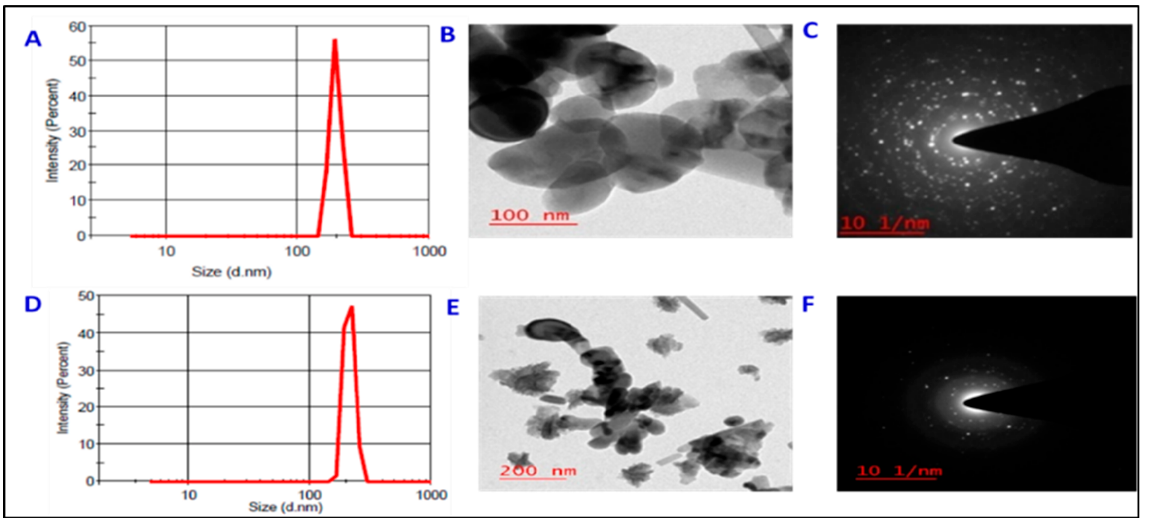
Figure 1. ( A ) DLS size distribution of ZnO-NPs, ( B ) TEM image of ZnO-NPs, ( C ) SAED pattern of the ZnO-nanocrystals, ( D ) DLS size distribution of Fe 3 O 4 -NPs, ( E ) TEM image of Fe 3 O 4 -NPs and ( F ) SAED pattern of the Fe 3 O 4 -nanocrystals.